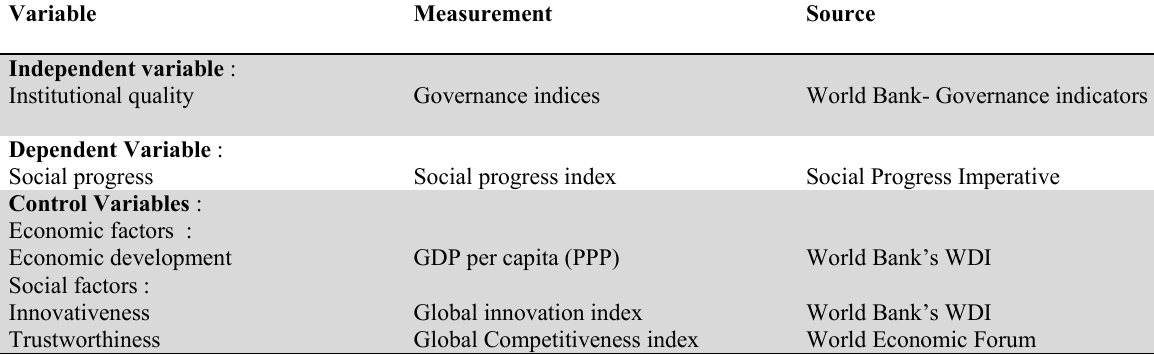
Variable and data sources Variable